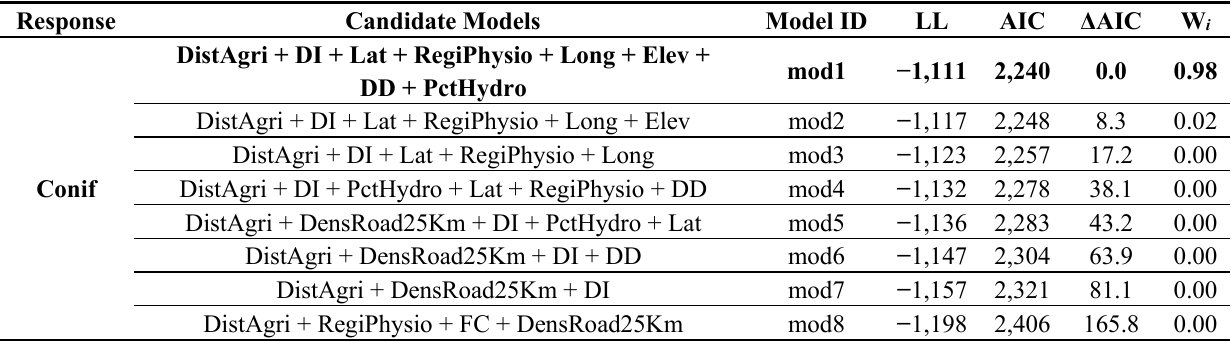
Table A1. Description and best models of occurrence based on Akaike’s information criterion